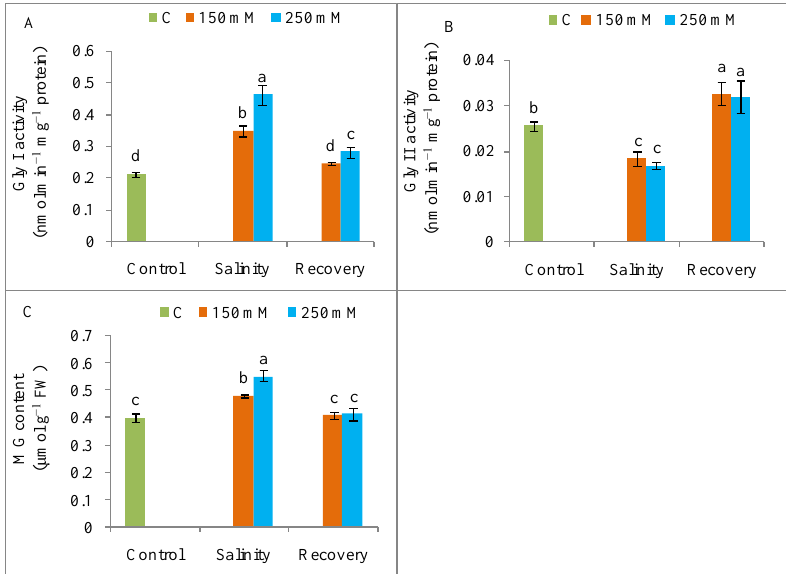
Figure 14. Methylglyoxalase detoxification ( A ) and activities of glyoxalase enzymes ( B ) Gly I, ( C ) Gly II in tomato plants under salinity (150 and 250 mM NaCl) and after a 48 h recovery period. Data means (±SD) were calculated from three replications. Statistically significant values are indicated by dissimilar letters (Fisher’s LSD test, P ≤ 0.05).